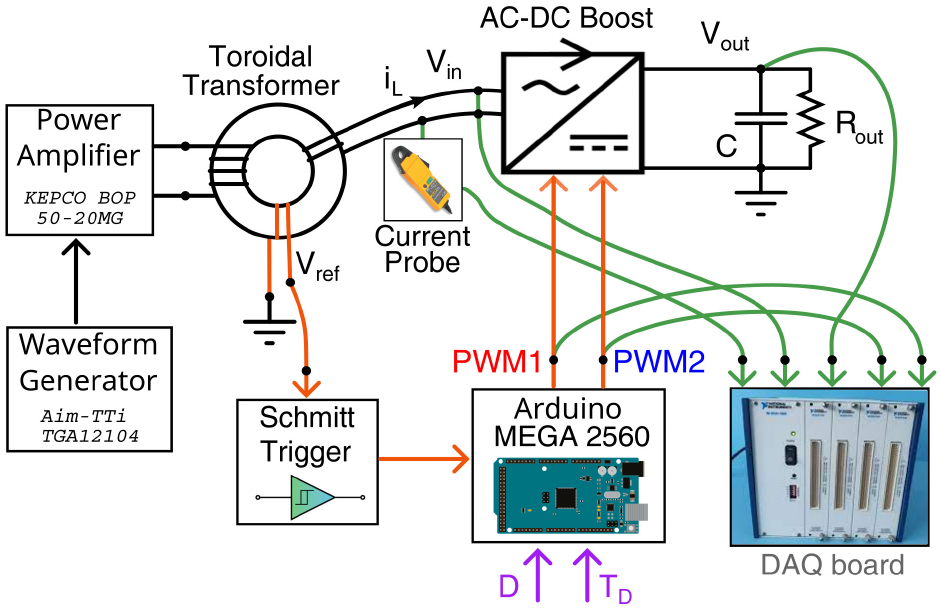
Figure 6. Experimental setup: the two controllable parameters “D” and “T D ” are in purple; the orange lines are signals exploited for control purposes; and the green lines are the measured